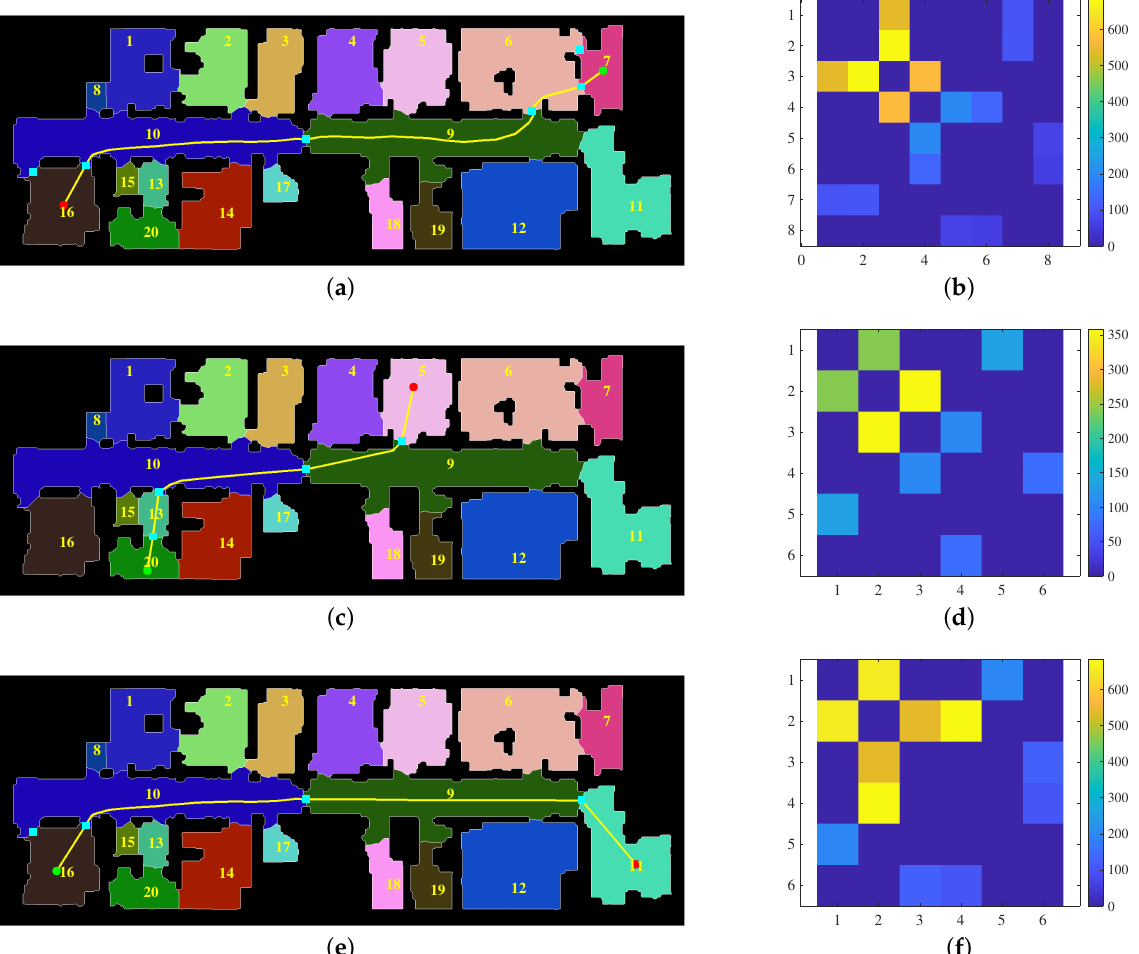
Figure 6. Hierarchical path-planning results: ( a , c , e ) The global paths from starts (red dots) to goals (green dots); the cyan squares are the selected junction nodes. ( b , d , f ) The cost matrix for the chosen junction nodes, the start, and the